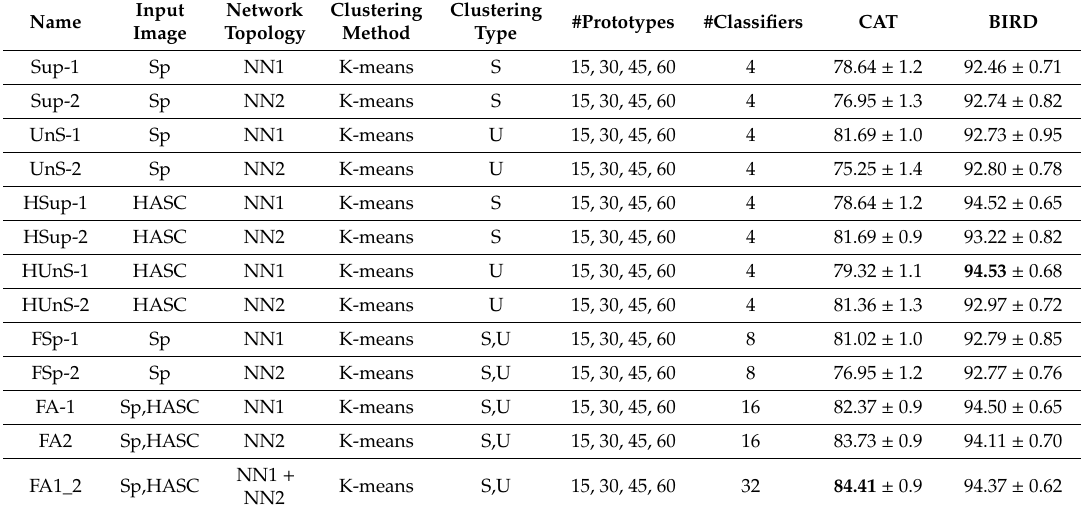
Table 2. Performance obtained by k-means clustering: accuracy ± standard deviation.